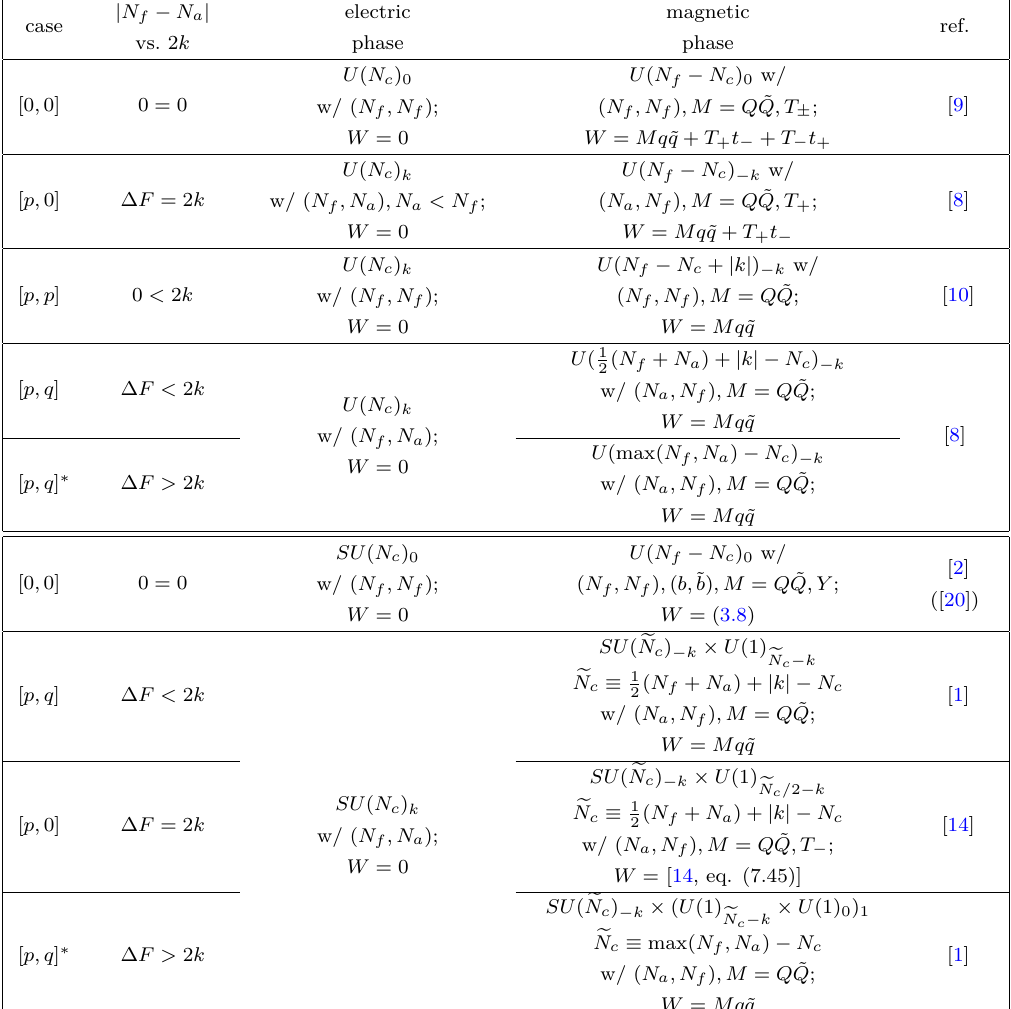
Table 1 . Summary of chiral dualities for U ( N c ) and SU ( N c ) SQCD with ( N f , N a ) ∈ ( N c , N c ) matter fields. Here U ( N c ) k ≡ U ( N c ) k,k = SU ( N c ) k × U (1) 0 (neglecting global issues). The notation ( U (1) × U (1)) 1 means there is a mixed CS term at level 1 between the two gauge U (1) ’s. (One of the two factors may be the abelian center of U ( e N c ) .) The dictionary between the non-negative integers p, q and the effective CS level k ± on the Coulomb branch is as in formulae